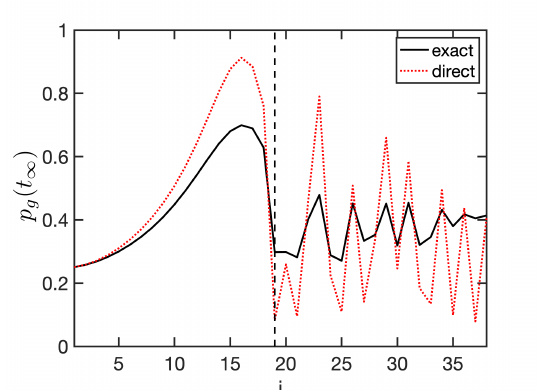
(see text) of one g